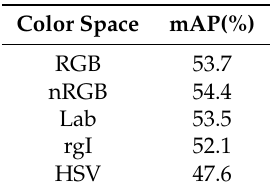
Table 1. Recognition accuracies for different color spaces (%).